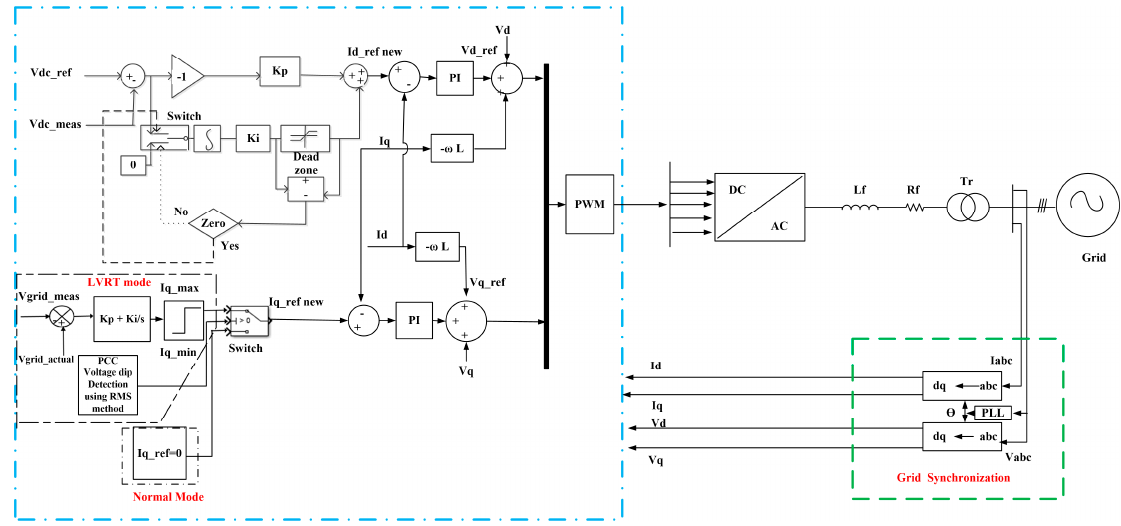
Figure 6. The proposed inverter control scheme of reactive power injection.